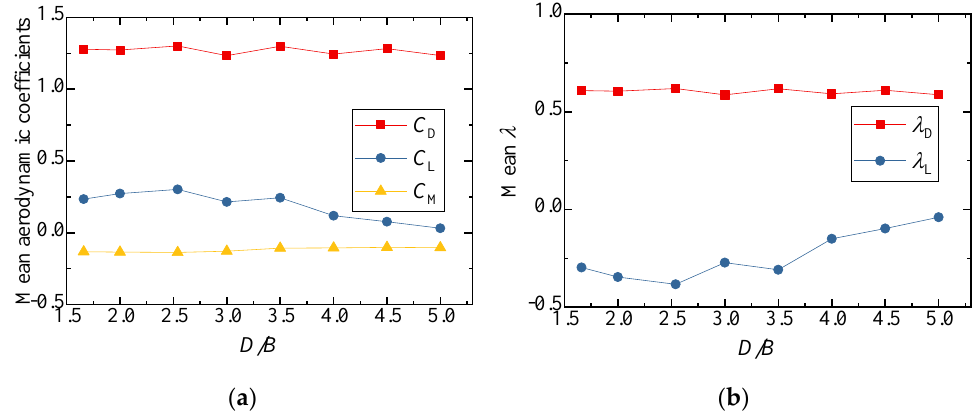
Figure 19. Comparison of the ( a ) aerodynamic coefficients and ( b ) interference factor of the down- stream bridge for the various D/B ratios investigated in Case 3.